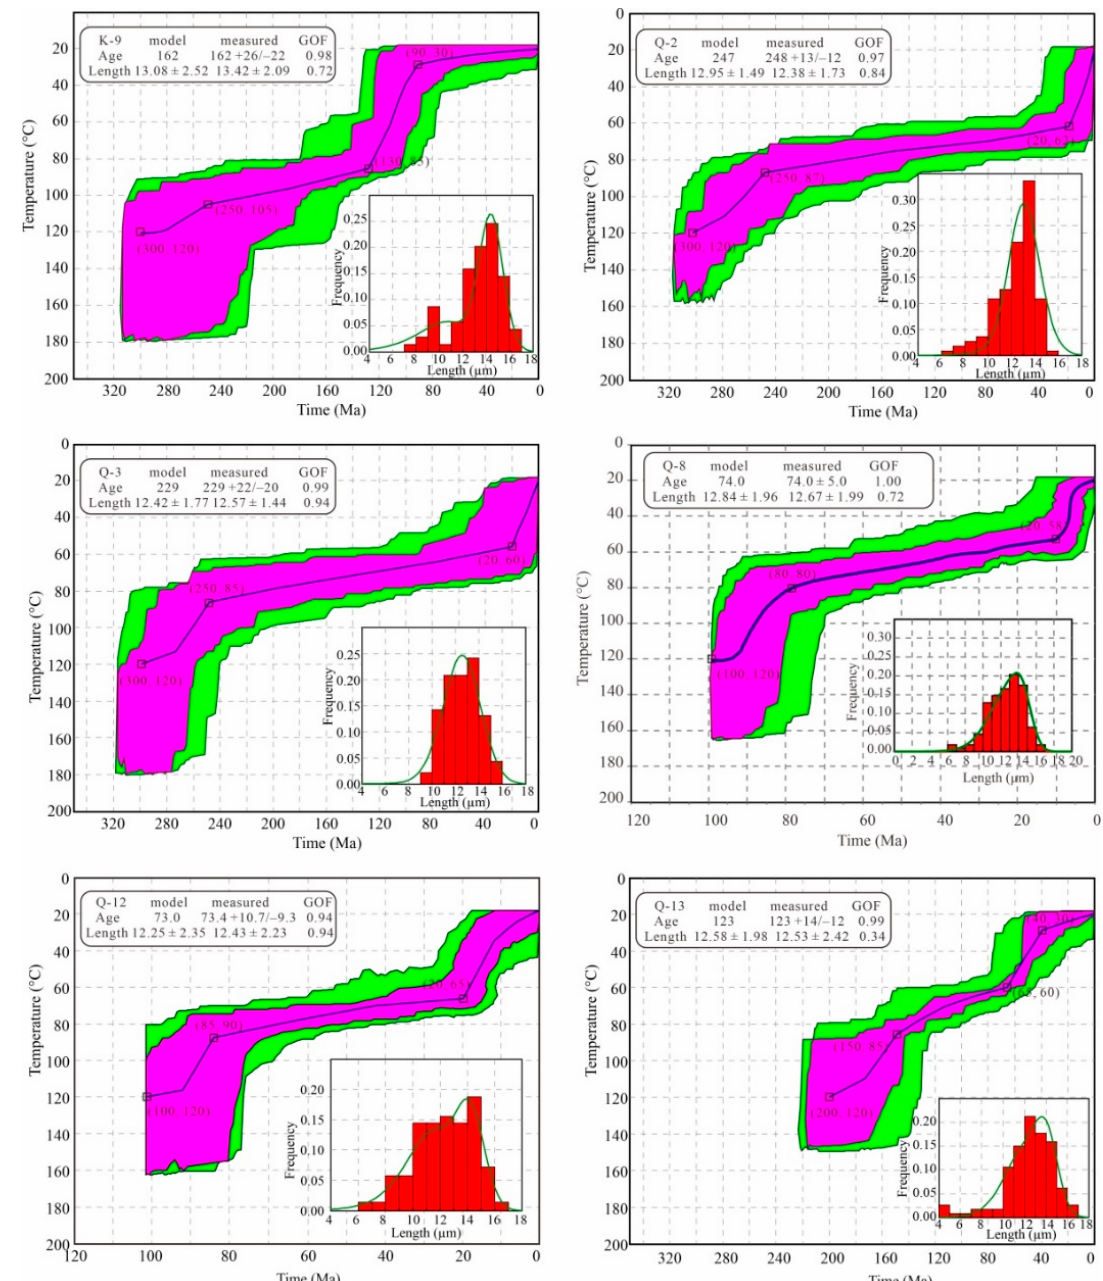
Figure 5. HeFTy thermal path evolution simulation results and histograms of AFT lengths of samples from Karameri and Qinglidi Mountains. The purple areas represent highly credible intervals of simulation. The green areas represent acceptable intervals. The black lines represent the best fit